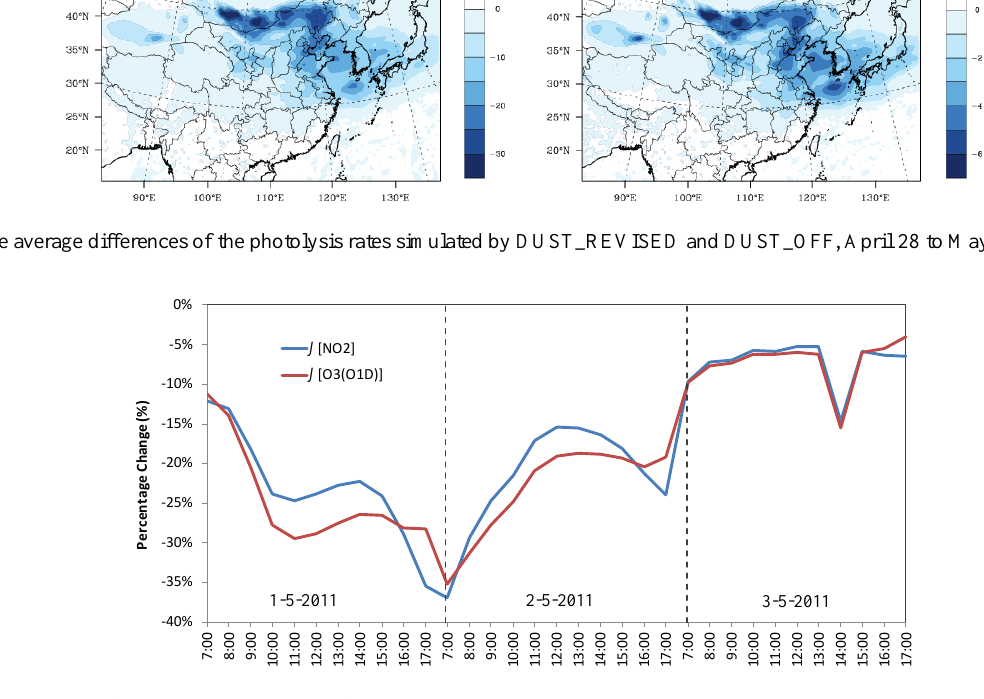
Fig. 12. Diurnal cycle of the percentage change of the NO 2 photolysis rate and the O 3 photolysis rate in Shanghai, May 1 to May 3